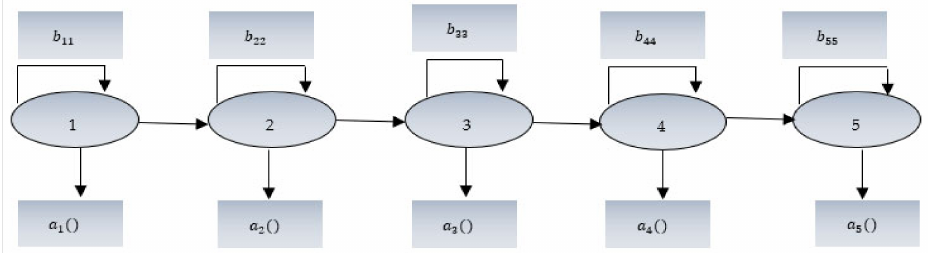
Figure 3. Face recognition using HMM (from